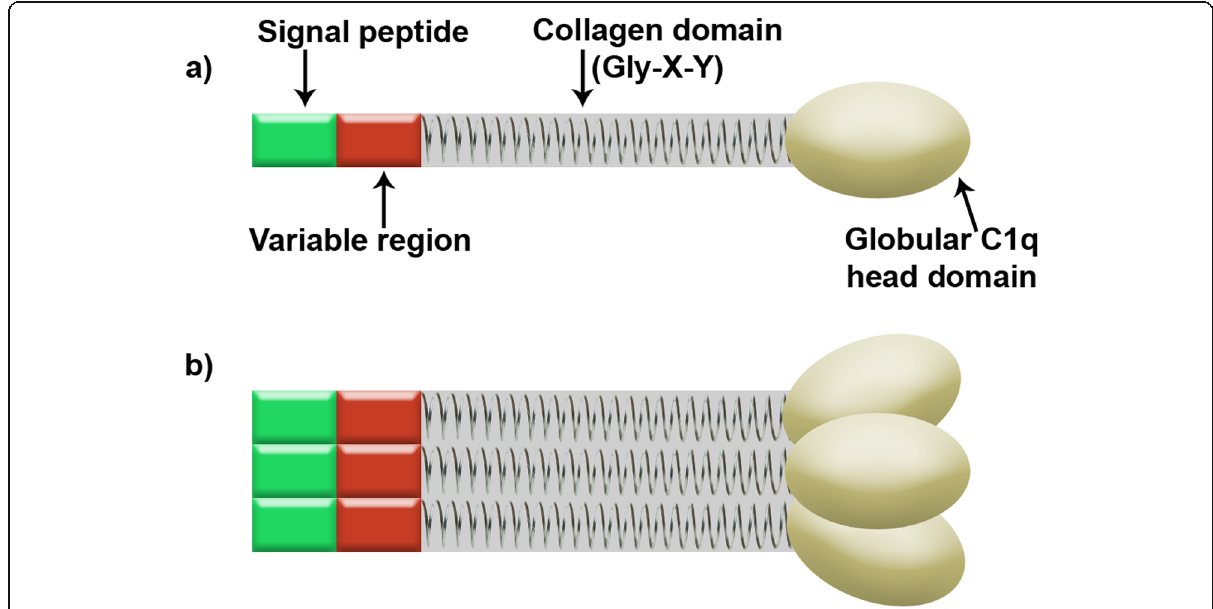
Fig. 1 Structure of CTRP, a Structure of monomeric protein; b Homotrimeric protein